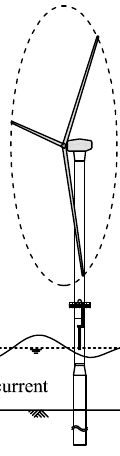
Figure 3. Schematic representation of a three-bladed monopile-based offshore wind turbine exposed to wind, waves and